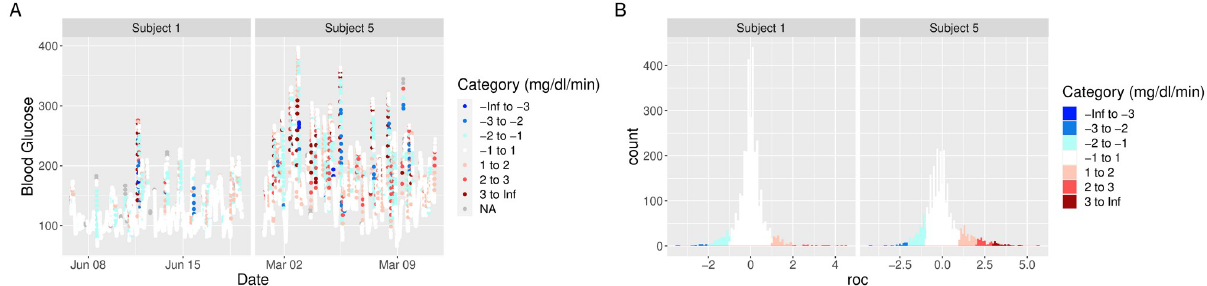
Fig 4. Rate of change visualizations. (A) time-series and (B) histogram plots of rate of change for two selected subjects from example dataset.